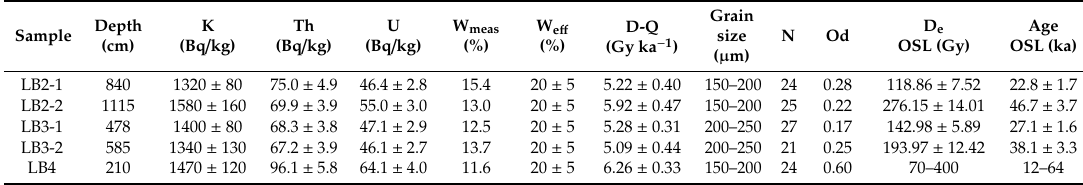
Table 3. OSL (Optically stimulated Luminescence) datings